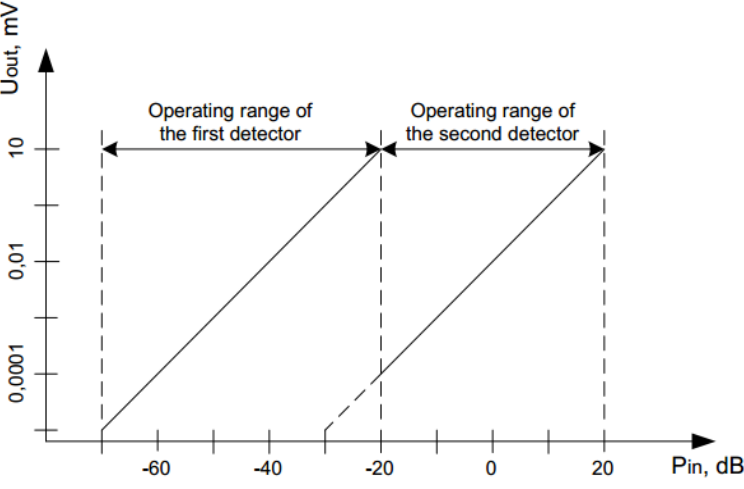
Fig. 2. Output voltages vs input power for two-path